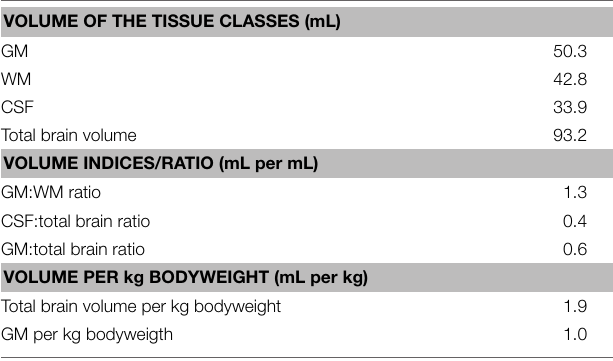
TABLE 2 | Tissue volume characteristics of the ovine T1w template.